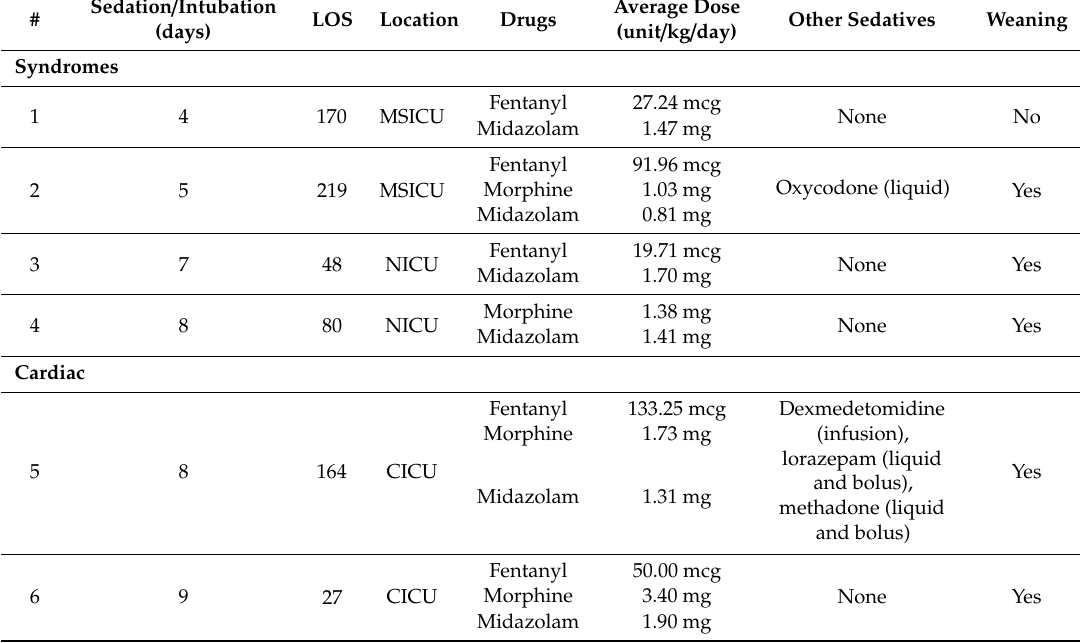
Table 3. Sedation management of patients undergoing surgical repair. Patients undergoing surgical treatment are arranged according to disease category (syndromes / multiple anomalies, cardiac, and congenital diaphragmatic hernia) and length of sedation. Presented data include sedation treatment and weaning for each infant from a single hospital admission (first, or only, hospital admission) at Boston Children’s Hospital. Patients numbered 1, 2, 5, 7, and 14 required multiple hospital admissions or multiple sedation treatments. Sedation period coincided with intubation. All patients were sedated with a combination of opioids (fentanyl and / or morphine) and benzodiazepines (midazolam), irrespective of intensive care location. Average daily dose (unit / kg / day), defined as the total dose of each drug received both as an infusion and boluses, increased with the length of sedation. Other additional pain and sedation medications administered included clonidine, dexmedetomidine, ketamine, lorazepam, methadone, and oxycodone (administered in the form of boluses, unless otherwise stated). Patient with sedation < 5 days did not require weaning following extubation. Asterisks (*) indicate patients were deceased at the time of